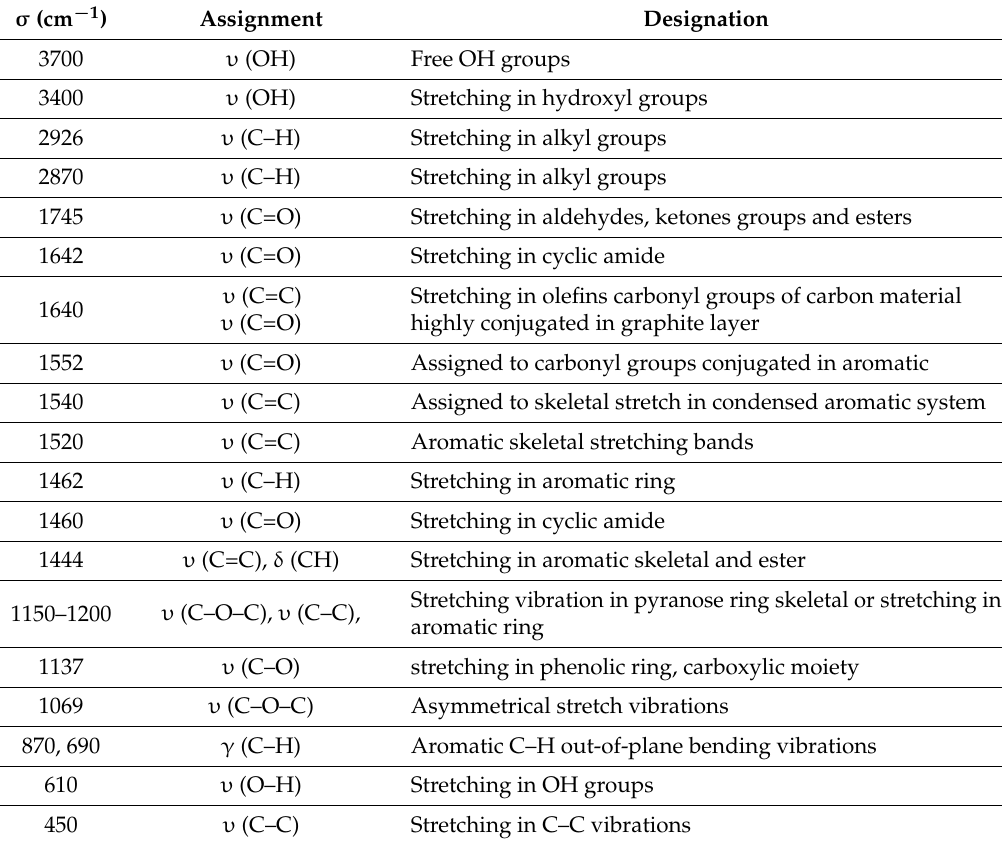
Assignment of Fourier transform infrared (FTIR) spectroscopy absorption bands of biomass-derived carbons